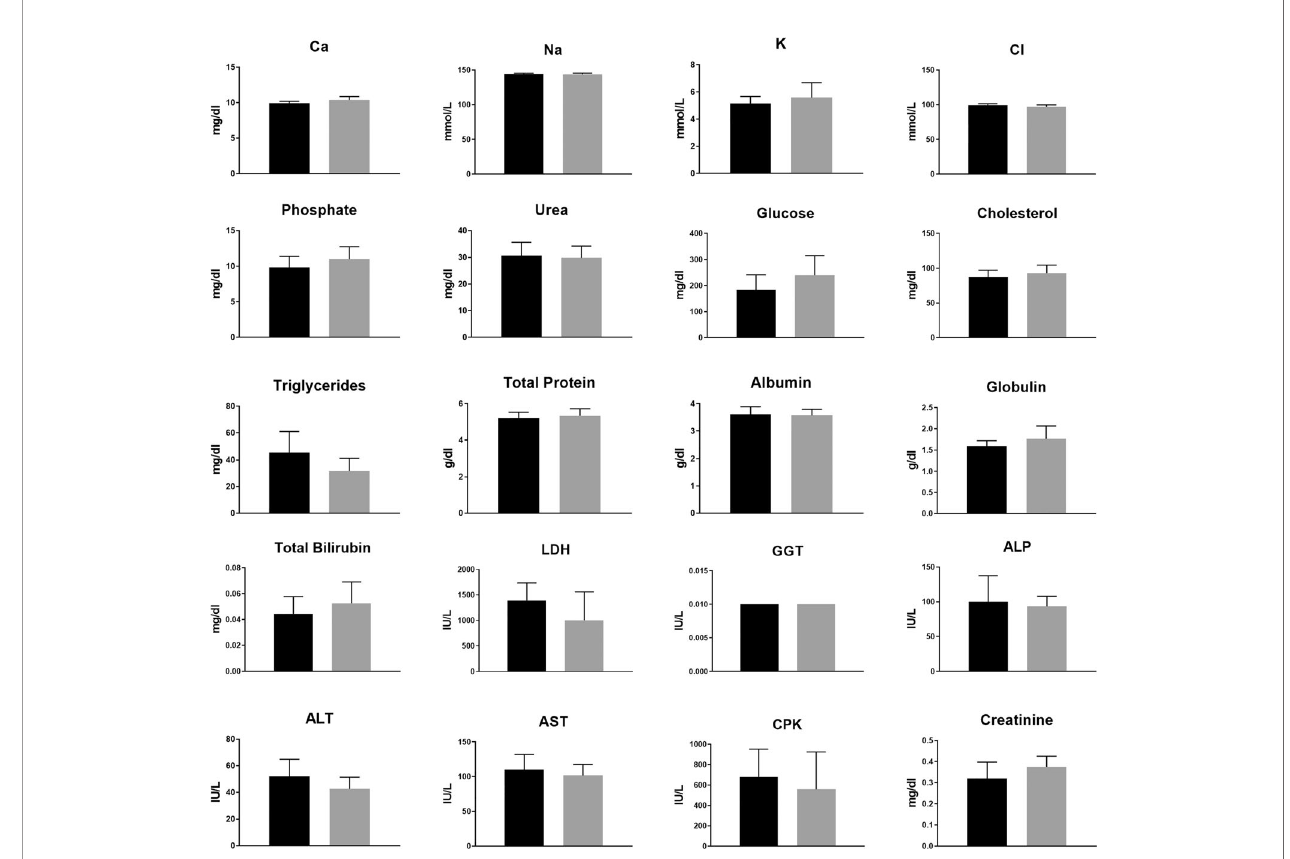
FIGURE 4 | Animal blood biochemistry at the end of 2 weeks of sham or 200 kHz TTFields treatment. Average ± standard deviations at study end are shown for control animals versus animals treated with TTFields. TTFields vs control non-signi fi cant; Student ’ s t-test. (LDH, lactate dehydrogenase; GGT, gamma-glutamyl transferase; ALP, alkaline phosphatase; ALT, alanine aminotransferase; AST, aspartate aminotransferase; CPK, creatinine